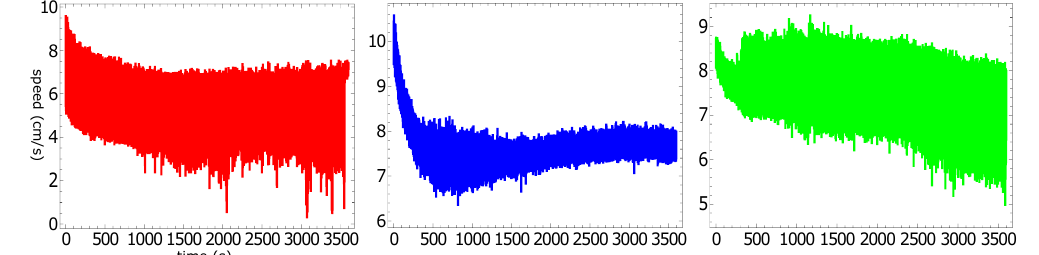
Figure 12. The speed of a pill made of 10% polypropylene, 45% camphene, and 45% camphor plastic as functions of time observed in the three independent experiments (cf. Figure 10).